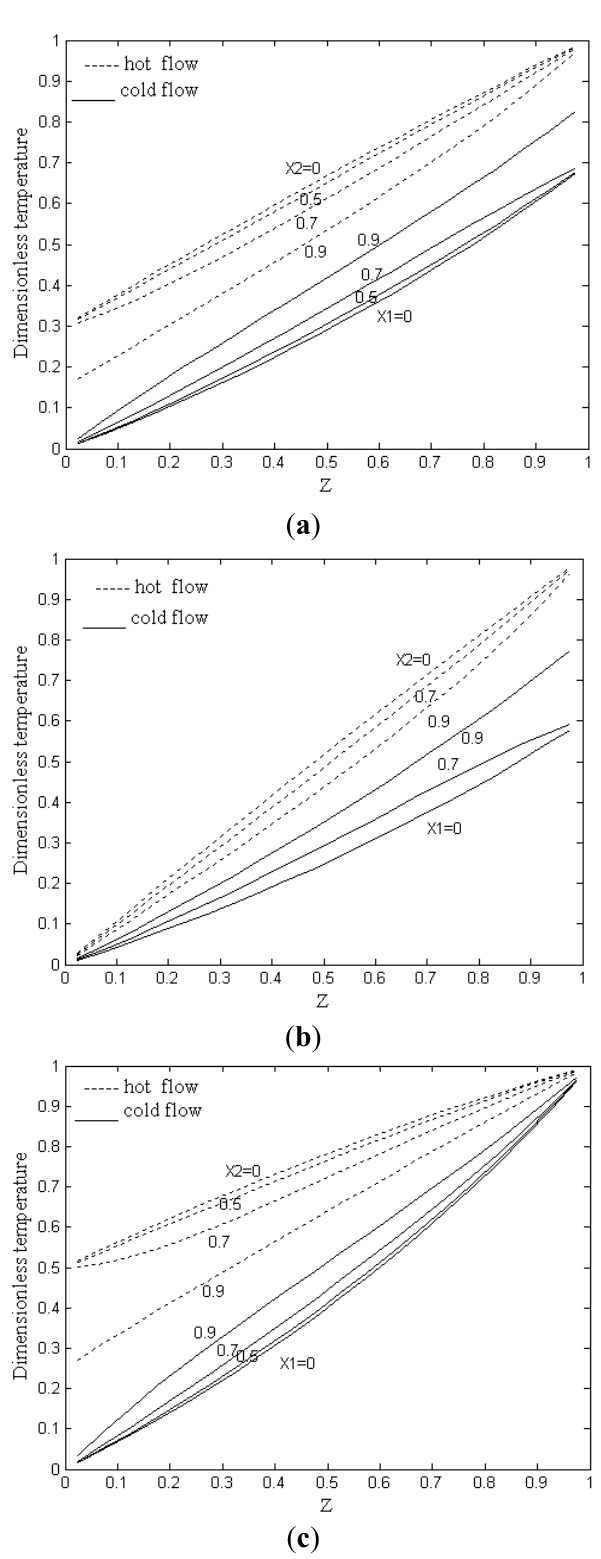
Figure 5. Temperature distribution for a counter flow plate heat exchanger (Turbulent flow). ( a ) Two dimensional temperature distribution for K = 1, H = 0.5, K W = 0 and K t = 0.33; ( b ) Two dimensional temperature distribution for K = 1, H = 1, K W = 0, and K t = 0.33; ( c ) Two dimensional temperature distribution for K = 1, H = 2, K W = 0 and K t =